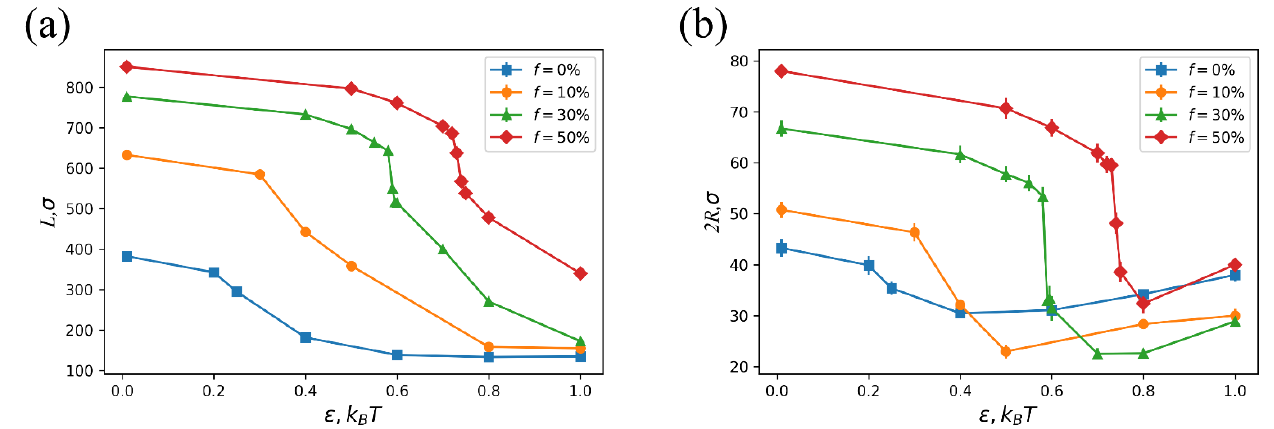
Figure 6. Microgel contour length L ( a ) and thickness 2 R ( b ) vs. interaction parameter ε between beads. Different curves correspond to the different fraction of charged groups in the microgel. The molecular weight and subchain length of the microgel are N = 50,000 and M = 20, respectively. The initial aspect ratio is A = 10.